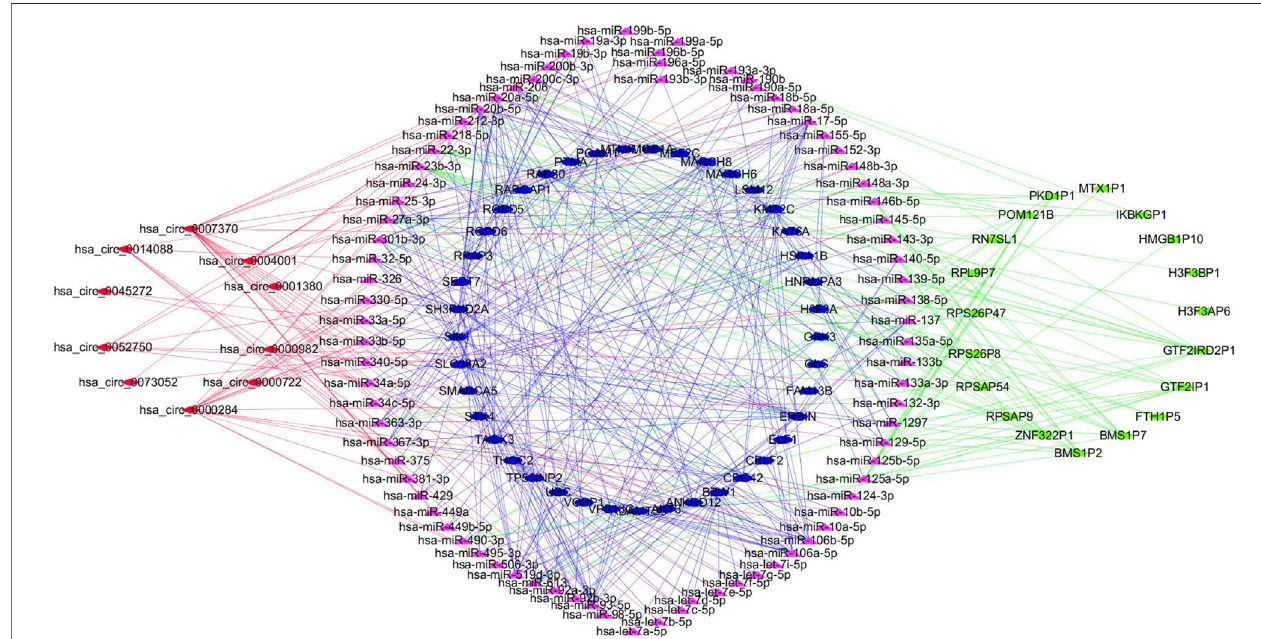
FIGURE 2 | Detailed ceRNA networks and the most signi fi cant module were illustrated using Cytoscape.